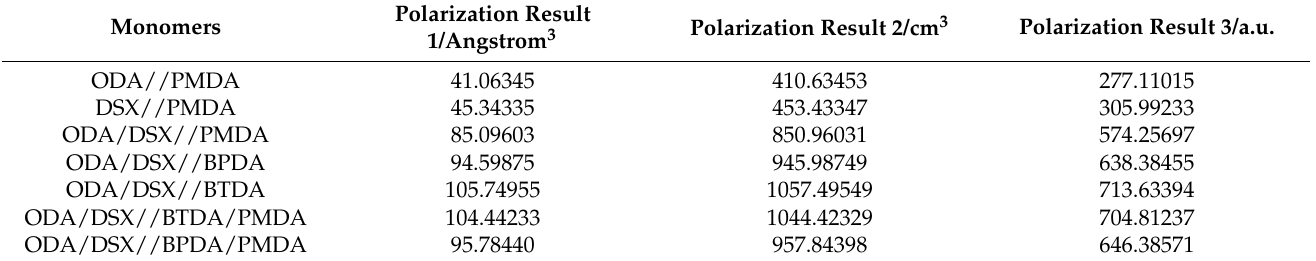
Table 1. Simulation results of the polarizability of PI films composed of each monomer